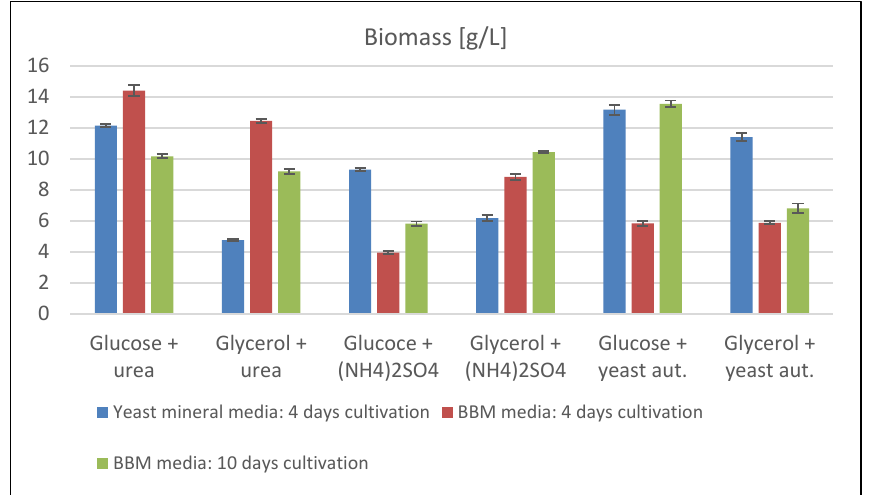
Figure 1. Biomass production of Rhodotorula kratochvilovae cultivated on different media types.